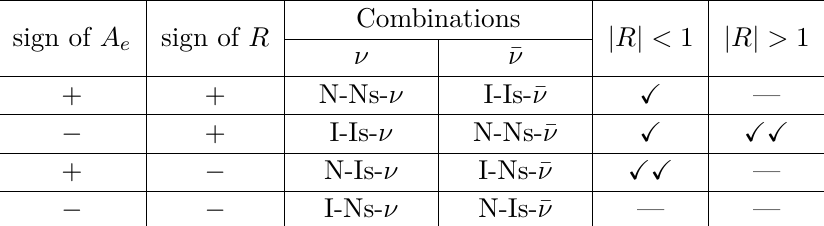
Table 5 . Modifications in the probabilities P ( ν µ → ν e ) and P (¯ ν µ → ¯ ν e ) due to the interplay between ∆ m 2 and matter effect. Here dash (‘—’) denotes the absence of significant enhancement 41 due to matter effects. The single tick (‘ X ’) denotes a small enhancement and double ticks (‘ XX ’) denote a large enhancement due to possible resonance-like